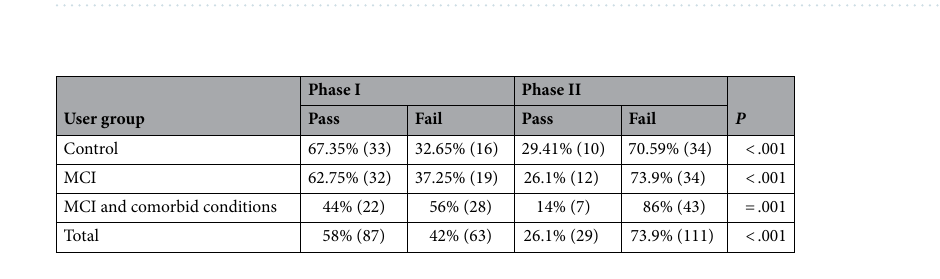
Table 2. Pass/ fail percentages based on Tier